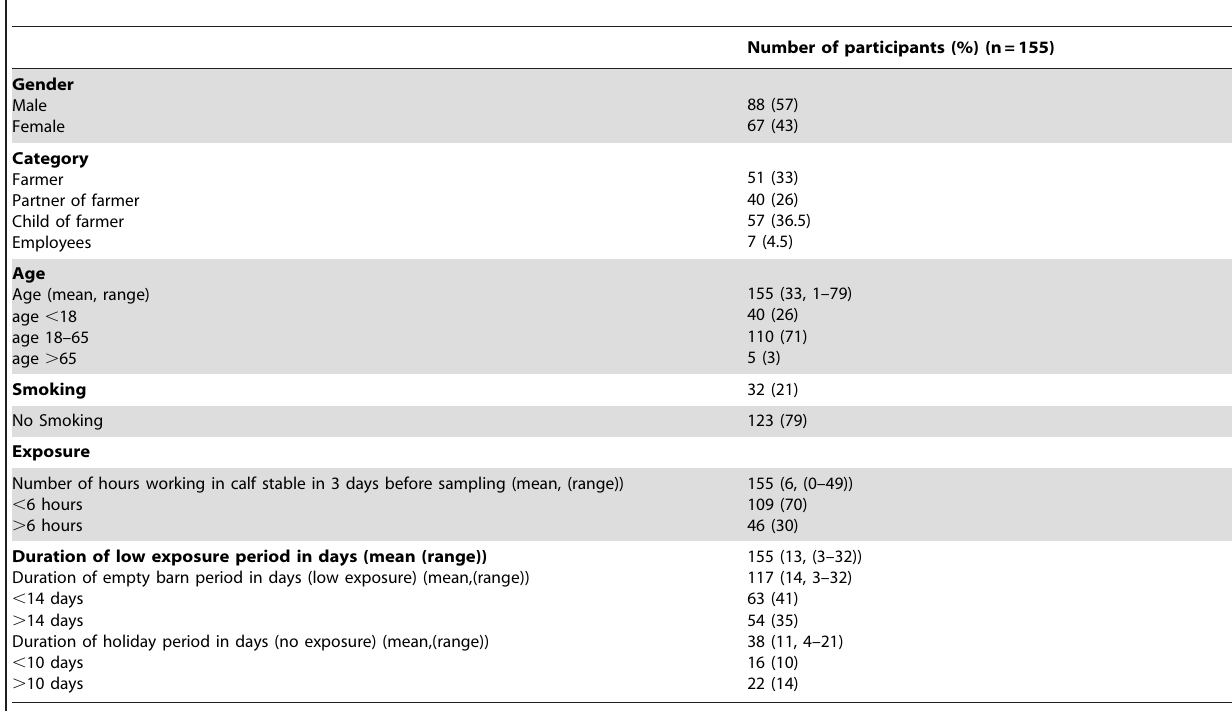
Table 1. Characteristics of study population of 155